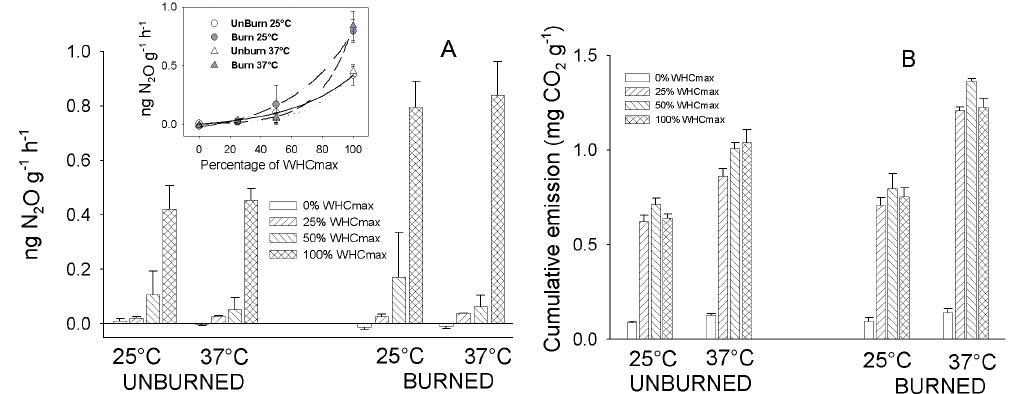
Fig. 7. (A) Emissions of N 2 O (ngN 2 Og − 1 soil dry weight h − 1 ) measured during the day of maximal N 2 O production after water addition (day 1) and (B) cumulative CO 2 emissions (mgCO 2 g − 1 soil dry weight) over 15 days from soil of burned and unburned plots incubated at 0, 25, 50 and 100% of maximal water holding capacity saturation (WHC max ) and at two temperatures (25 ◦ C or 37 ◦ C). In the small insert is N 2 O emissions (ngN 2 Og − 1 soil dry weight h − 1 ) vs. % of WHC max . Bars are one standard deviation.